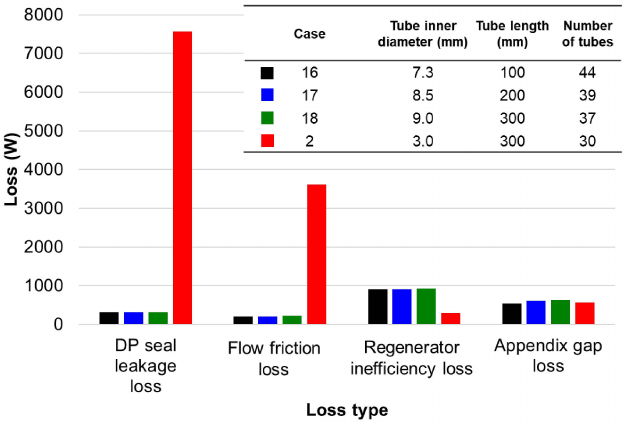
Figure 14. Major loss for the design condition that generates the maximum brake power for cases 16, 17, and 18 in Figure 11 and the major loss in the worst case 2 with the lowest brake power in Table